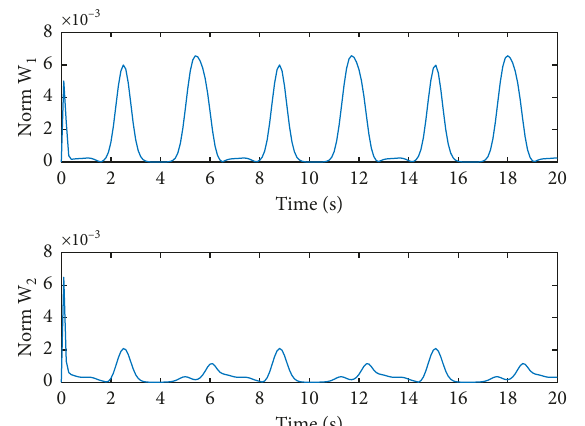
Figure 7: Estimation weights with the single NN-based controller.